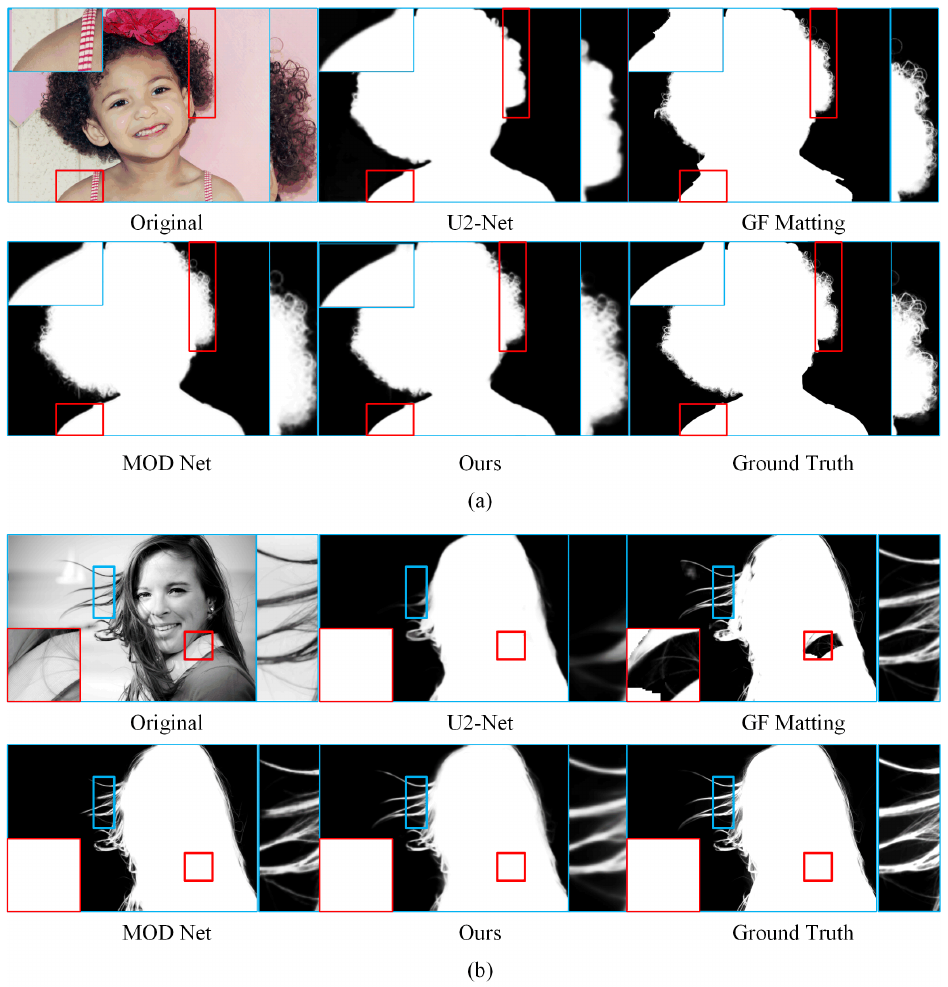
Figure 6. PPM-100 test set experimental results: ( a ) Chart 54 in the dataset; ( b ) Chart 21 in the da- taset.